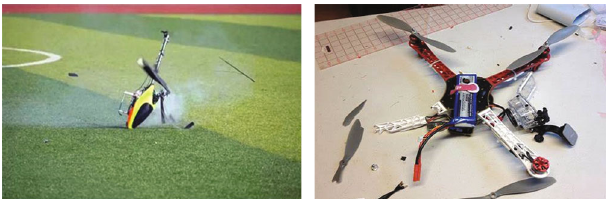
Figure 3: Airframe damage of UAV.